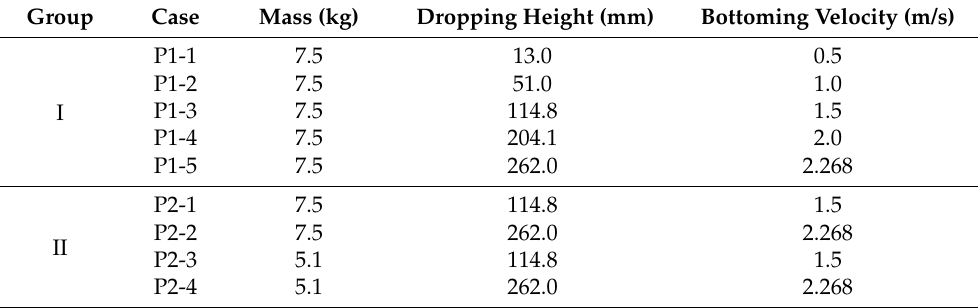
Table 12. Model test details.